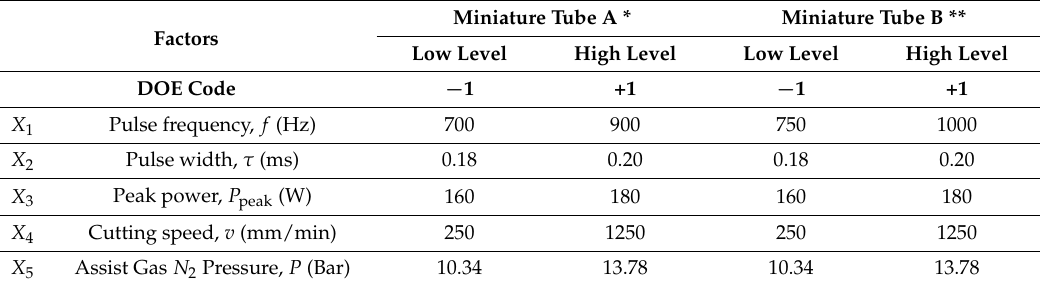
Table 5. Experimental factors for DOE.